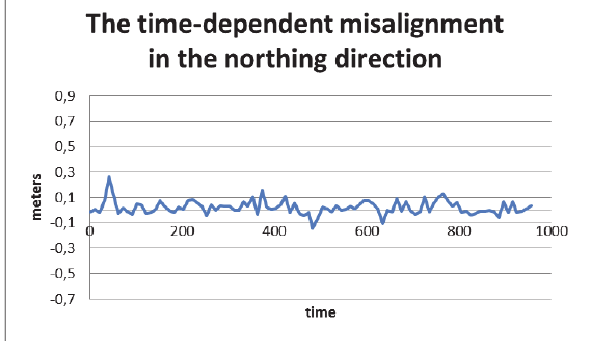
Figure 12. The misalignment of the BLS patch centre points in the northing direction after the time-based